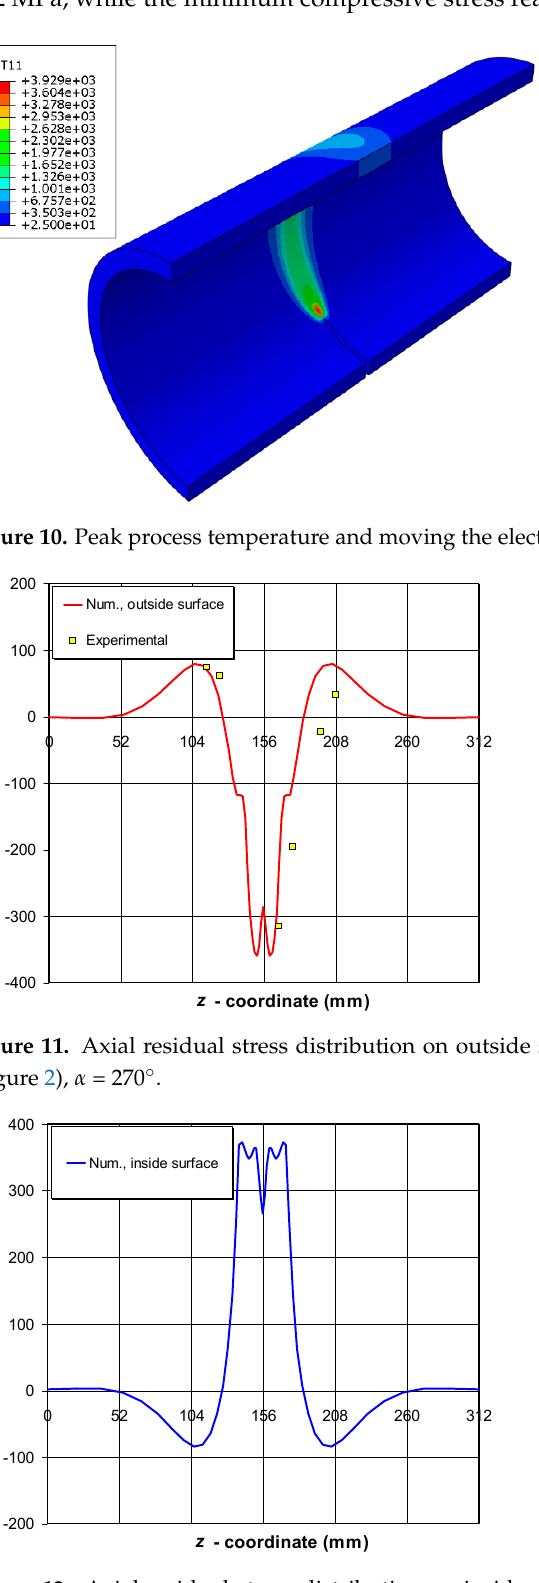
Figure 9. Temperature histories at three nodes (outside surface, z = 141 mm, α = 180°, α = 270° and